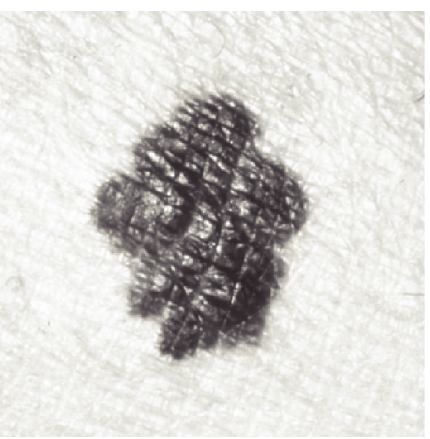
Figure 7: Test 2: ELM of a melanoma. Image size is 840 × 840.